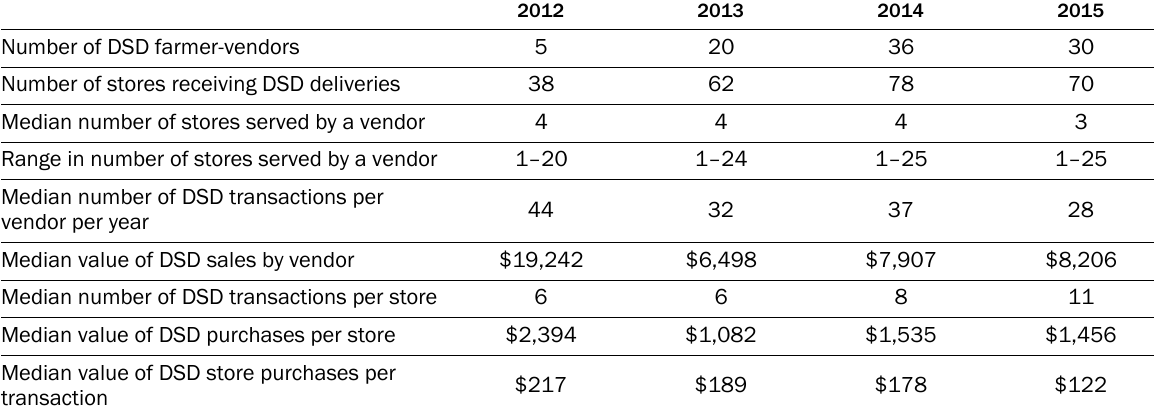
Table 2. Direct-Store-Delivery (DSD) Produce Purchases by Focal Grocery Store, 2012–2015,